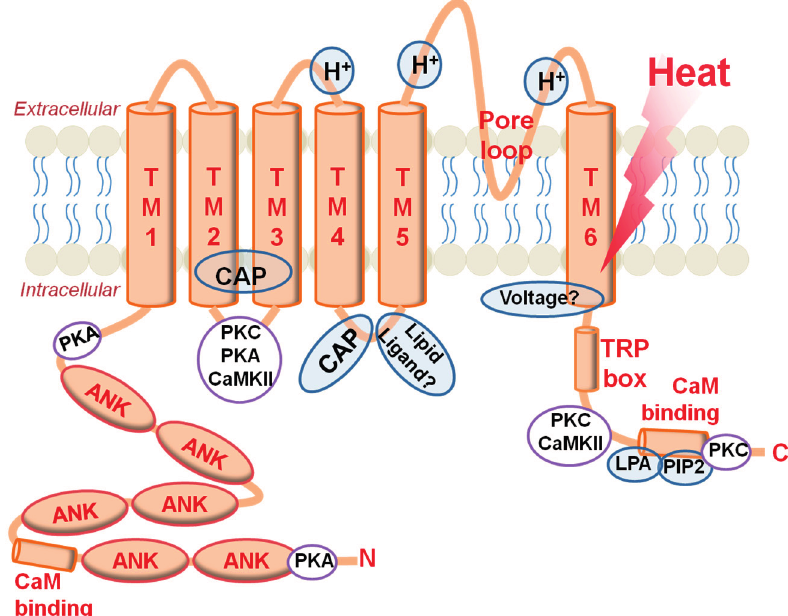
Figure 2. TRPV1 topology highlighting key domains, phosphorylation sites, and ligand binding pockets that affect gating functions. Abbreviations: H + , proton binding site; TM, transmembrane domain; CAP, capsaicin binding region; PKC, substrate regions for protein kinase C actions; PKA, substrate regions for protein kinase A actions; CaMKII, substrate regions for Ca 2+ /calmodulin-dependent protein kinase action; Voltage, predicted voltage-sensing domain; TRP box, conserved amino acids in TRPA, TRPC, TRPV, and TRPM subfamilies; CaM binding, calmodulin binding site; LPA, lysophosphatidic acid binding site; PIP2, phosphatidylinositol